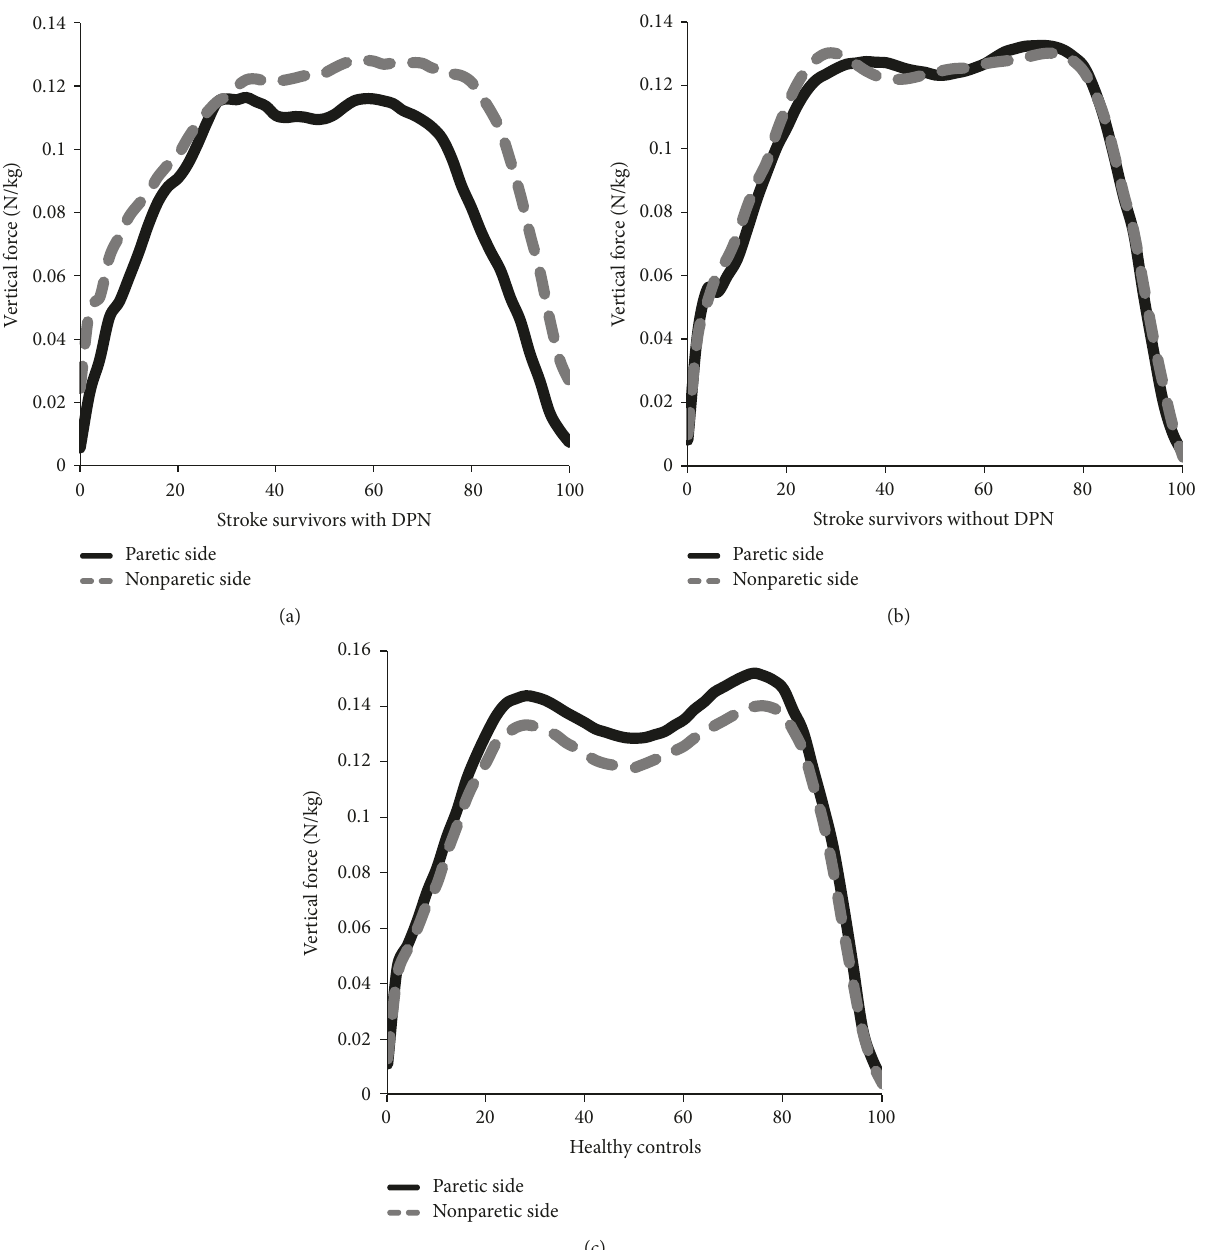
Figure 3: (a) Vertical forces of the paretic and nonparetic side of stroke survivors with DPN. (b) Vertical forces of the paretic and nonparetic side of stroke survivors without DPN. (c) Vertical forces of the paretic and nonparetic side of healthy controls. DPN: diabetic peripheral